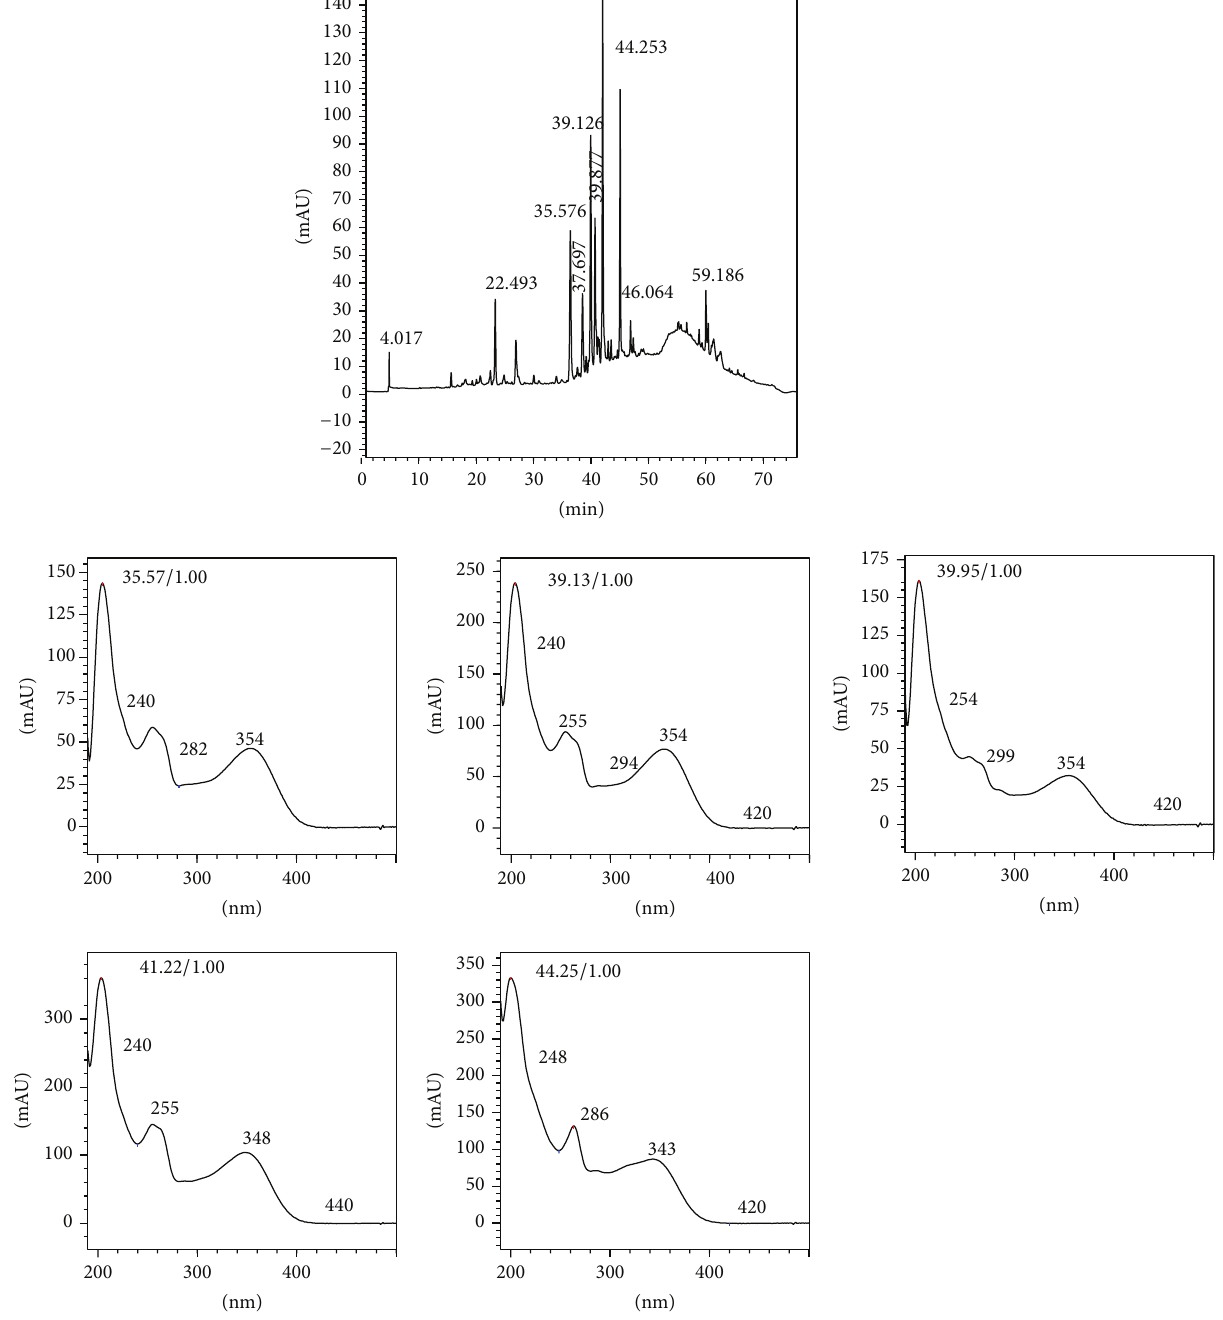
Figure 1: Chromatogram at 254 nm of the crude extract of the leaves of Ocotea notata by HPLC. Emphases for the UV spectrum of peaks 35.57, 39.13, 39.88, 41.22, and 44.25 min.